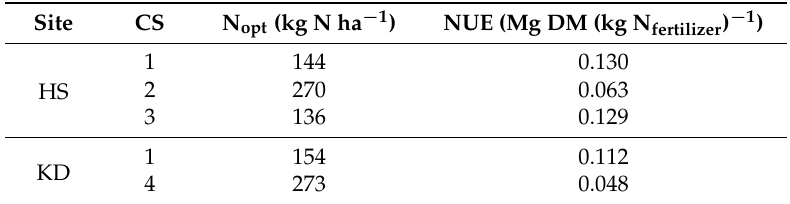
Table 10. Minimum N supply for maximum DM yield (N opt ), resulting from a linear-plateau-regression of dry matter yield over N supply; and fertilizer nitrogen-use efficiency (NUE). N opt and NUE are given separate for all cropping systems in HS and